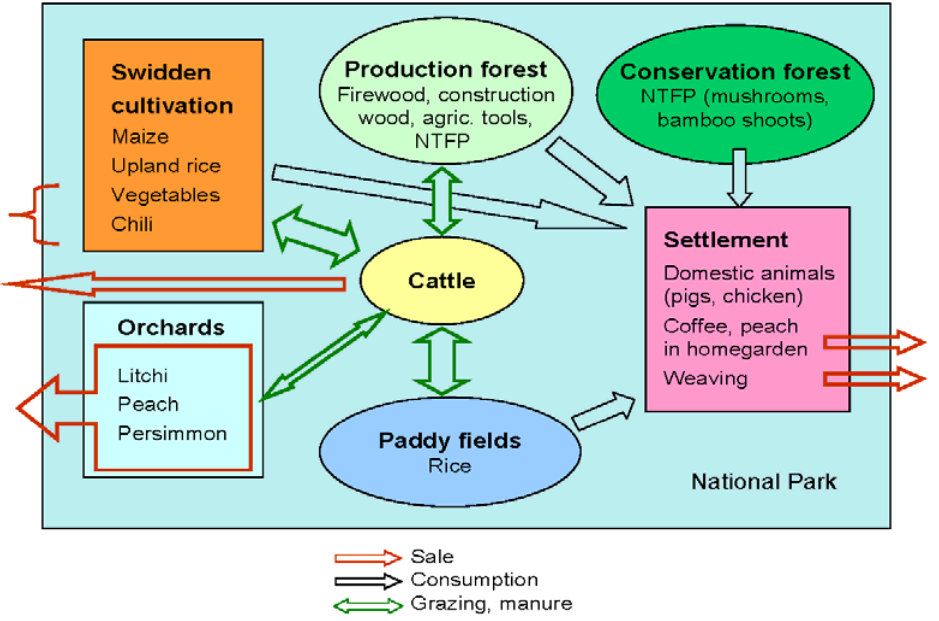
Figure 6. Integration of cattle with orchards, swidden fields, forests and homegardens in the Karen community of Mae Klang Luang, Northern